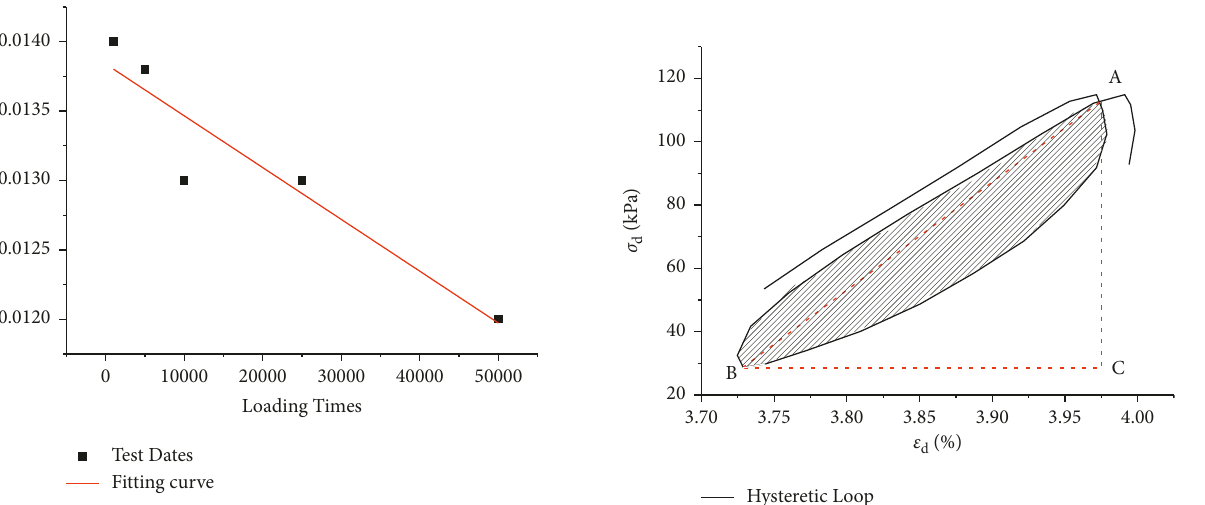
Figure 4: The relationship between hysteretic curve area and cycle times.